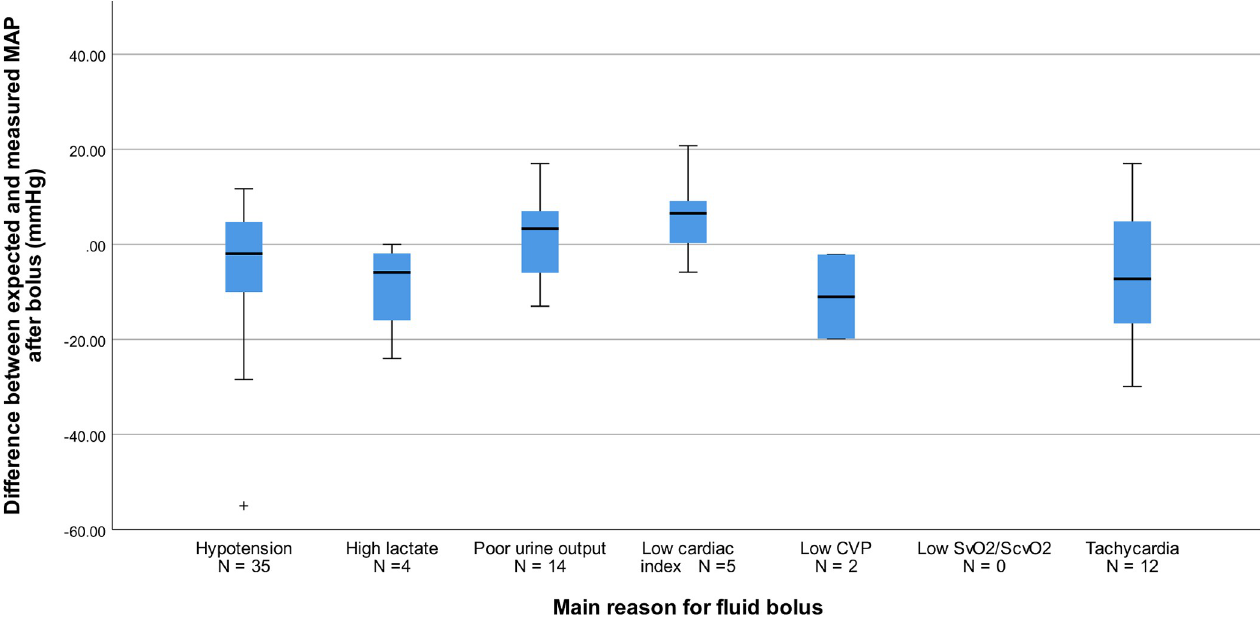
Fig 4. Boxplot of difference between measured and expected MAP by indication for bolus. Boxplot showing difference between expected and measured MAP by main reason for administration of fluid bolus. Positive values indicate a higher value for expected MAP compared to measured, and the inverse for negative values. MAP = Mean arterial pressure. CVP = Central venous pressure. ScvO2 = Central venous oxygen saturation. ScvO2 = Mixed venous saturation.